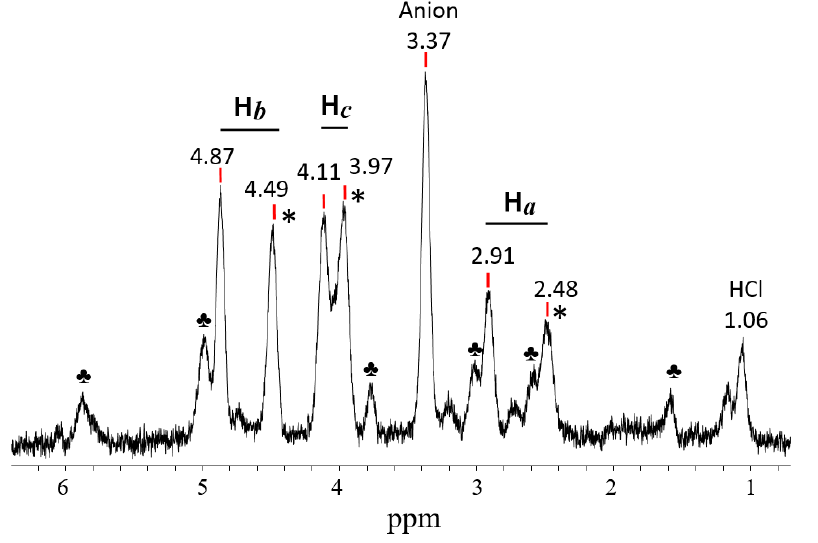
Figure 4. The 1 H NMR spectrum of the (C 2 H 3 ) 2 Cl + {Cl 11 − } salt dissolved in SO 2 ClF. The signals from the vinyl group that more strongly bonded with the Cl + atom are labeled with an asterisk. The signals from the decomposition products that grow with time are marked with the “ ♣ ” sign. Designations H a , H b and H c are given in the Scheme 2. Table 1. 1 H/ 13 C NMR chemical shifts (ppm) of the chloronium cation in the (C 2 H 3 ) 2 Cl + {Cl 11 − } salt in comparison with those of vinyl chloride (the signals marked with an asterisk belong to the second C 2 H 3 group, which differs from the first